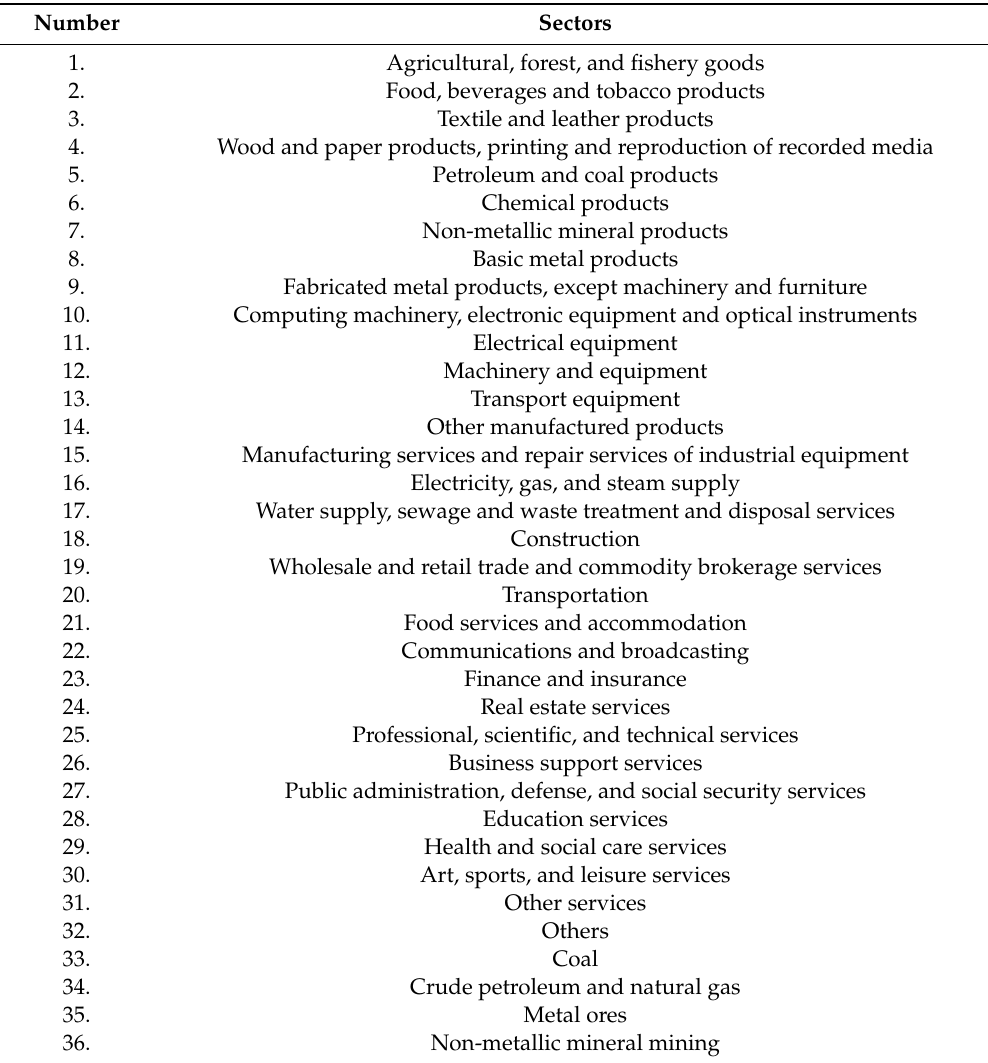
Table 1. Sector classification adopted in this